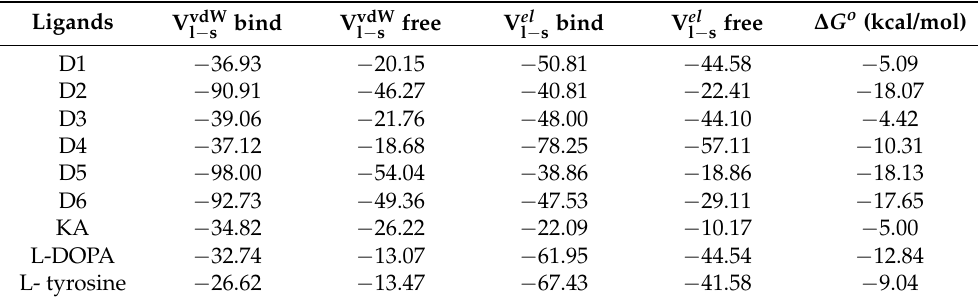
Table 3. Binding free energies between natural substrates, KA, and its derivatives and the residues of tyrosinase binding site.